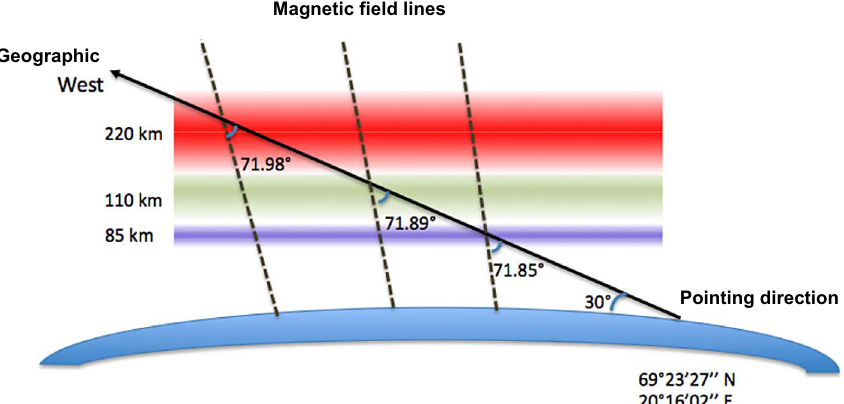
Fig. 2. Observation geometry during the campaign in Skibotn in March 2017.